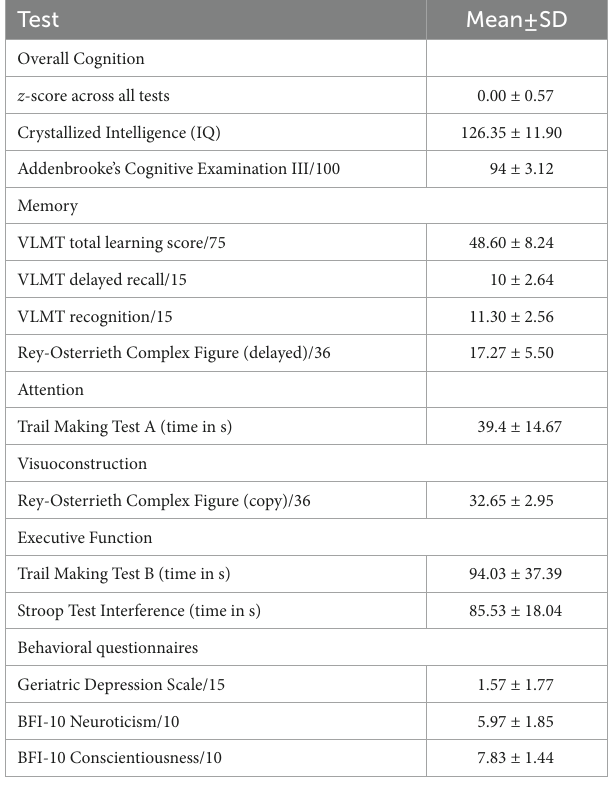
TABLE 1 Neuropsychological performance of the study sample ( n =